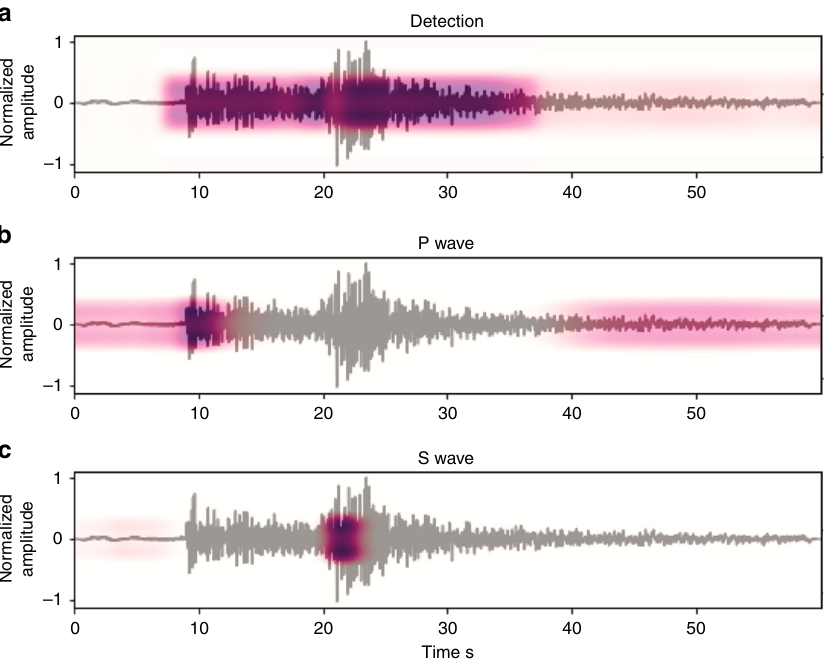
Fig. 3 Attention weights. Input waveform overlain by contextual information - output of the attention layers for a transformer (I in Fig 1), b local attention for P-phase (II in Fig 1), and c the local attention for S-phase (III in Fig (Supplementary Fig. 9) and three traditional (Kurtosis 17 , Filter- Picker 18 , and AIC 19 ) (Supplementary Fig. 10) auto pickers. We